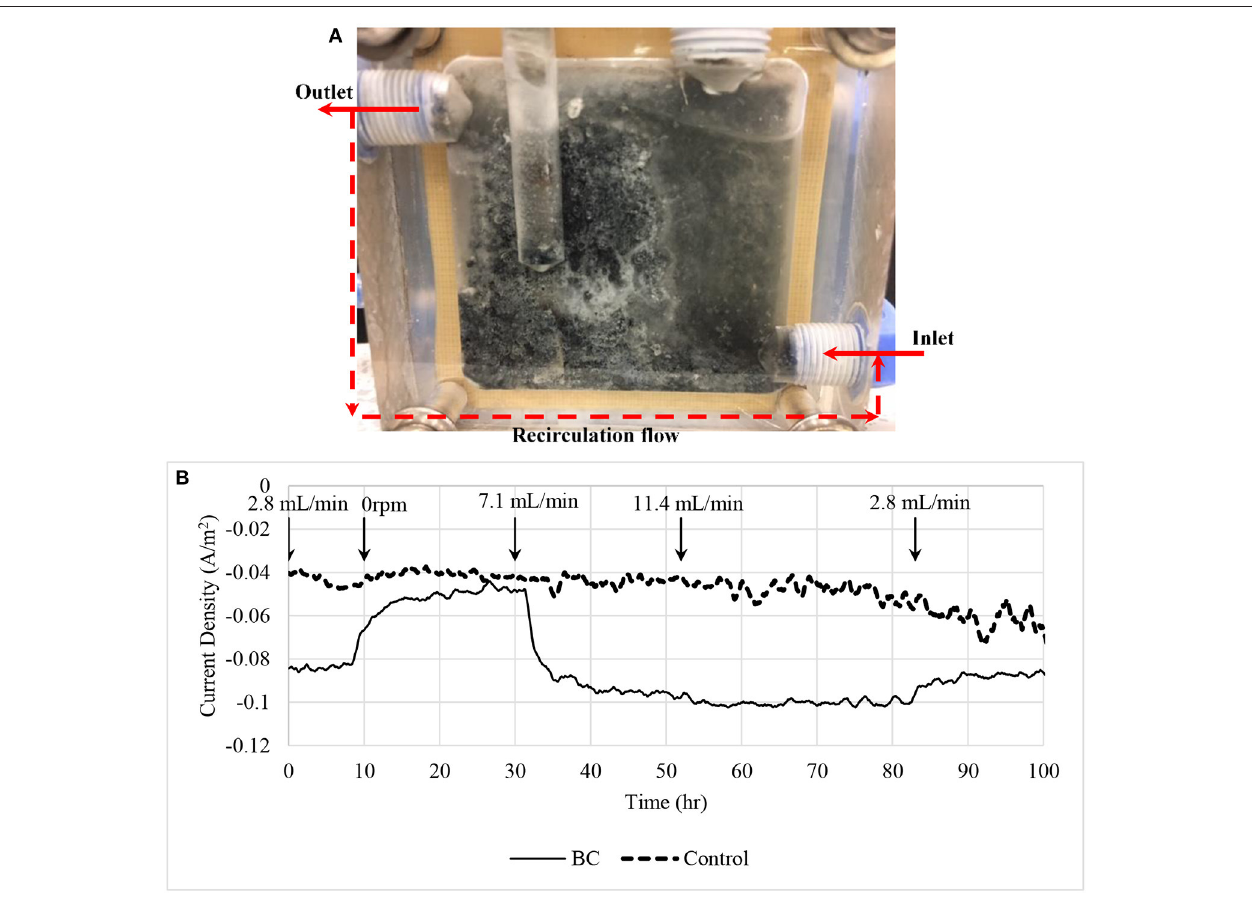
FIGURE 9 | (A) Biocathode after the experiments. White crystallization and black biomass were appeared on the surface of the electrode causing current density dropped. (B) Current density affected by mass transport limitation. A recirculation flow line was connected between inlet and outlet to recycle the catholyte in order to reduce the mass transfer limitation. A control using 7.1 mL/min recycle flow rate was included in the figure for comparison purpose.